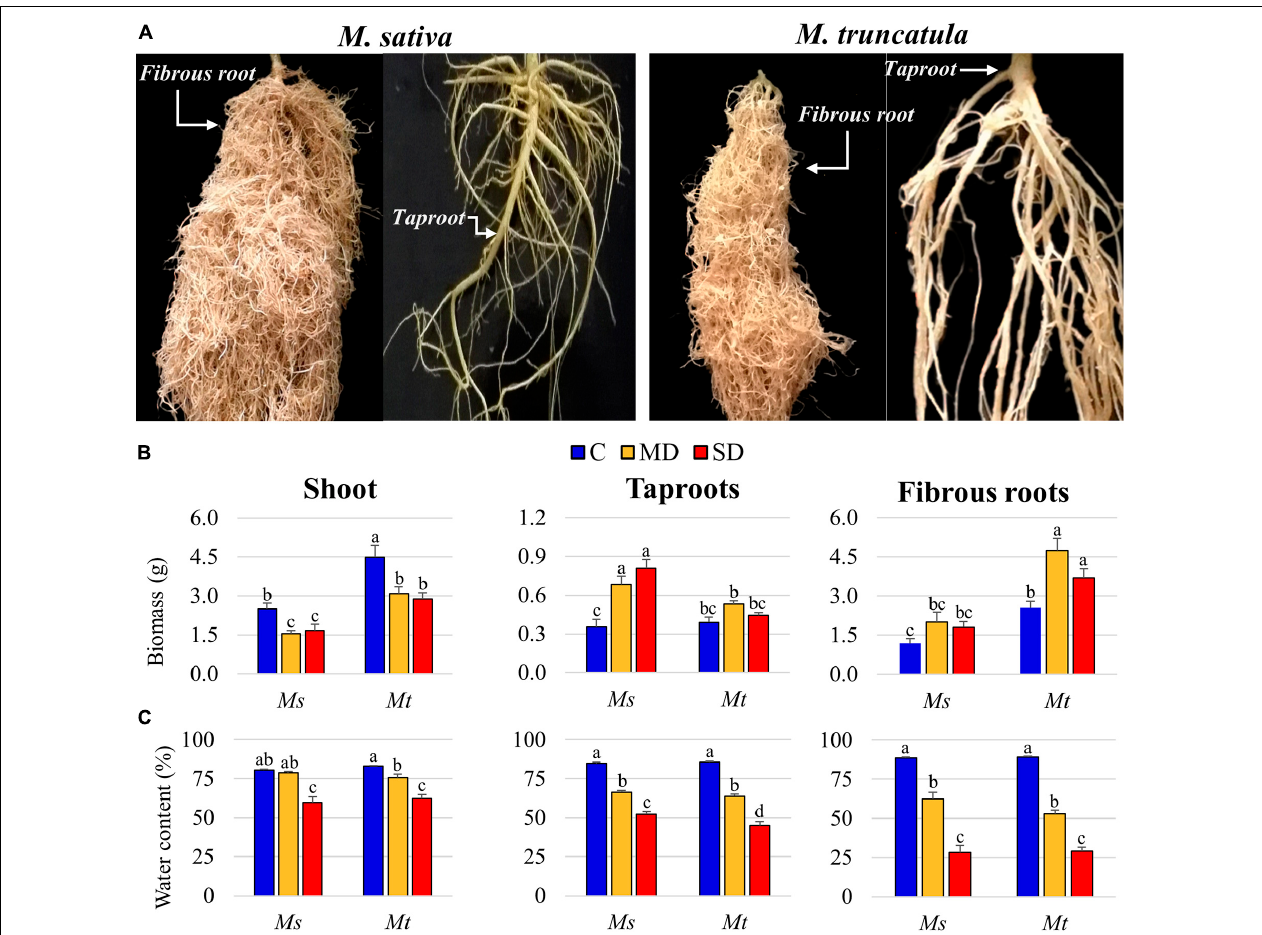
FIGURE 1 | Physiological characterization of the plants. (A) Images of 8-week old Medicago sativa ( Ms ) (left) and M. truncatula ( Mt ) (right) taproot (tapR) and fibrous root (fibR) systems. (B) Biomass and (C) water content of Ms and Mt plants under control (C), moderate water deficit (MD), and severe water deficit (SD) conditions. Bars represent means ± SEs ( n = 7 biological replicates). Different letters indicate significant differences according to a Duncan-test ( P ≤ 0.05).